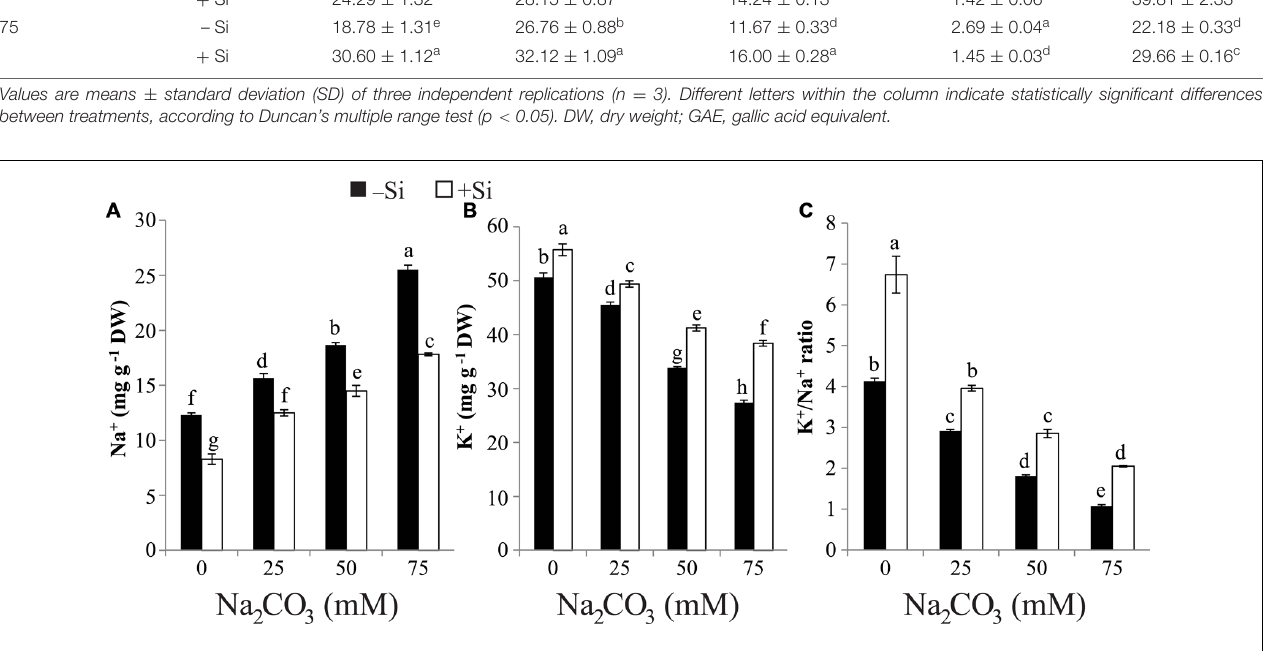
Frontiers in Plant Science |